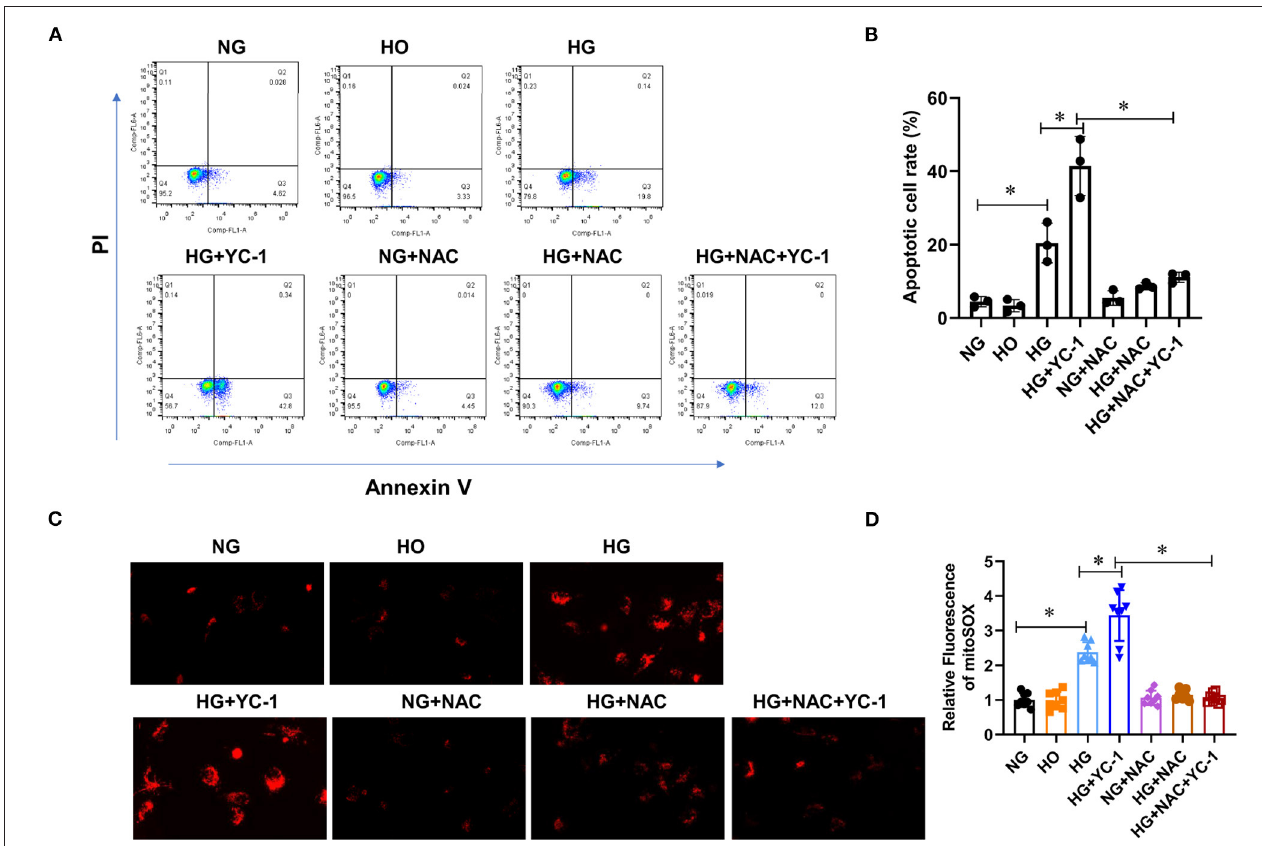
FIGURE 3 | HIF-1 α -Parkin/PINK1-mediated mitophagy prevented apoptosis and ROS production in HK-2 cells subjected to HG exposure. (A,B) . The level of apoptosis was quantified using CytoFLEX after annexin V and PI labeling. Apoptosis levels were significantly increased under high glucose conditions and further increased with YC- 1. This effect was reversed with NAC. * p < 0.05. vs. indicated group. (C,D) . Mitochondrial ROS production was measured using Image J software after MitoSOX staining. High glucose and inhibition of HIF-1 α significantly increased intracellular ROS levels, while NAC reversed this trend. * p < 0.05. vs. indicated group. HIF-1 α , Hypoxia-Inducible Factor-1; Parkin/PINK1, Parkin/PTEN Induced Putative Kinase1; YC-1, Lificiguat; ROS, Reactive Oxygen Species; NAC, N-Acetyl-L-Cysteine; HG, High